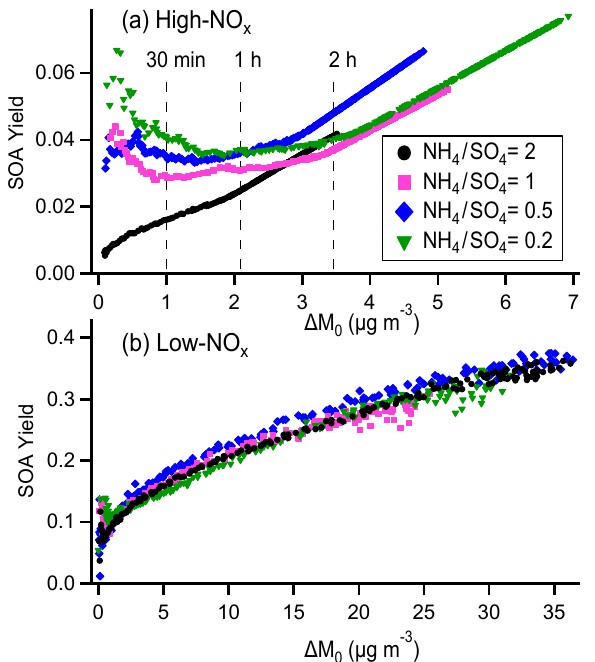
Figure 3. SOA yields as a function of organic mass concentrations for experiments using seed particles with varied acidity levels un- der (a) high- and (b) low-NO x conditions. The dashed lines in (a) represent the irradiation time at approximately 30min, 1h, and 2h.